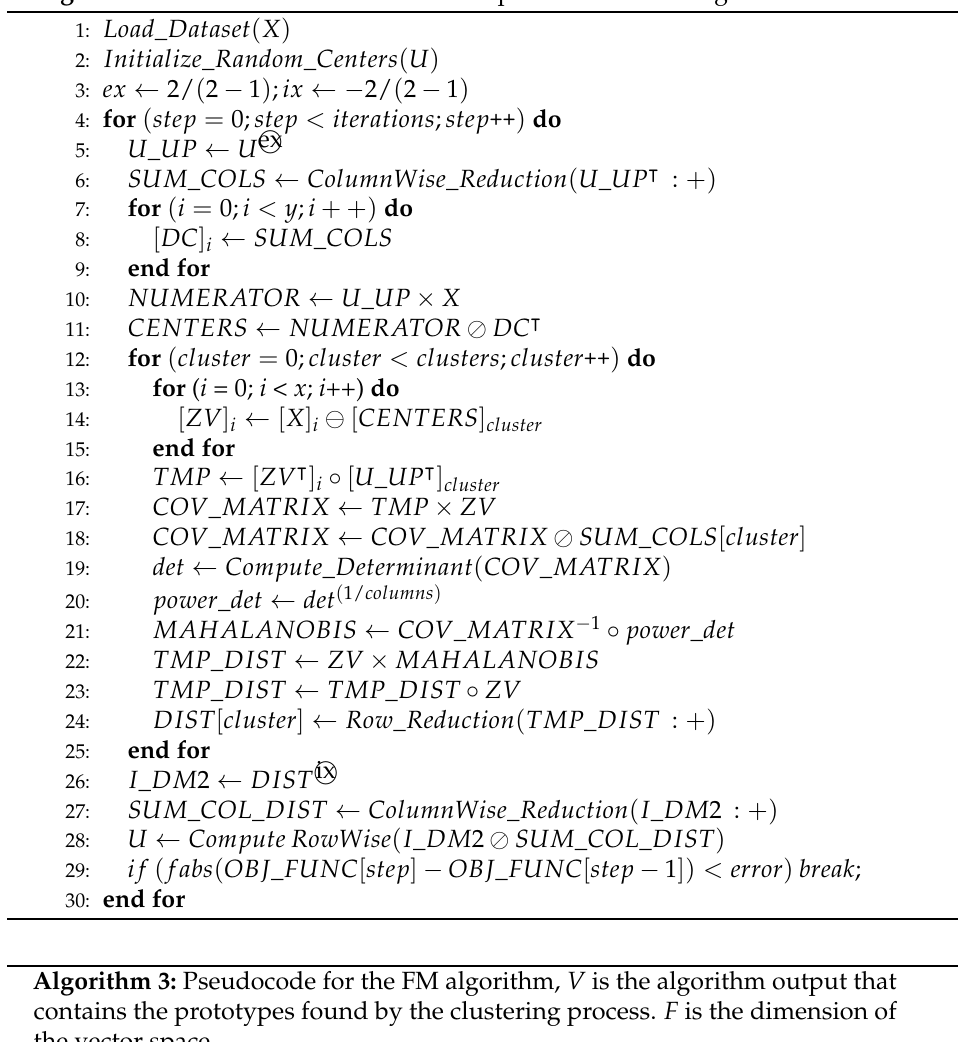
Algorithm 2: Pseudocode for the main loop of the GK-FCM algorithm.